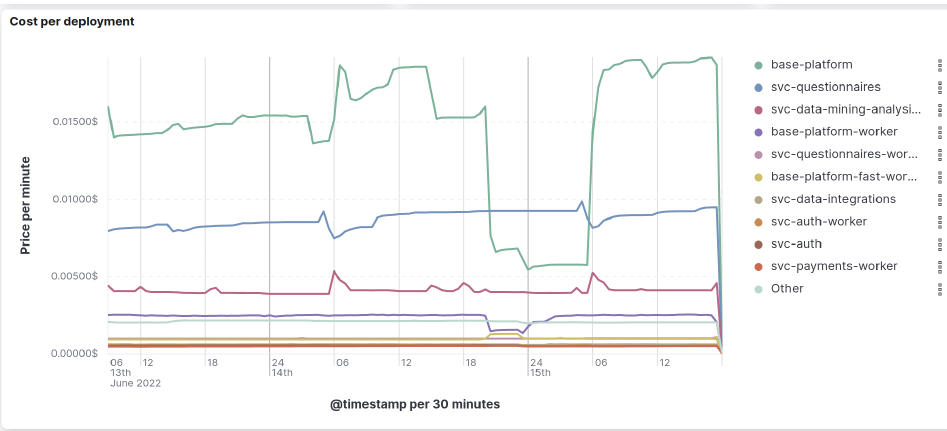
Figure 9. Deployment cost comparison in the production